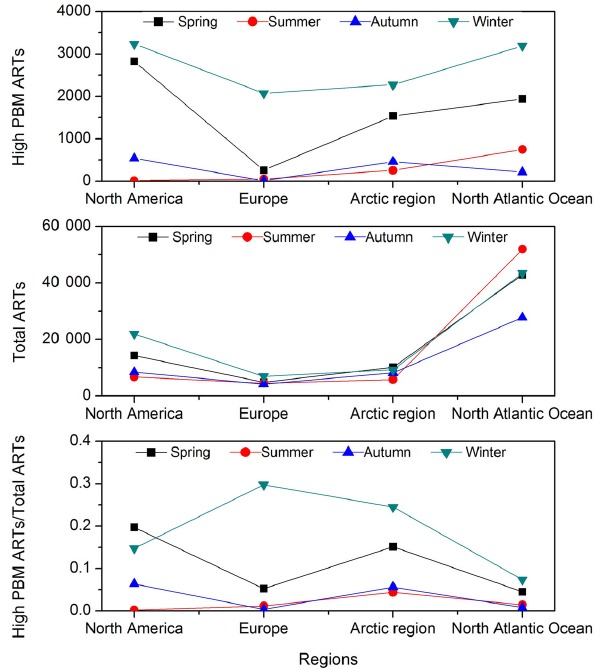
Figure 9. Seasonal variations in air masses residence times associ- ated with high PBM events (high PBM ARTs, top), total residence times of all the air masses (Total ARTs, middle) and high PBM ARTs / Total ARTs ratios (bottom) in North America, Europe, Arc- tic region and North Atlantic